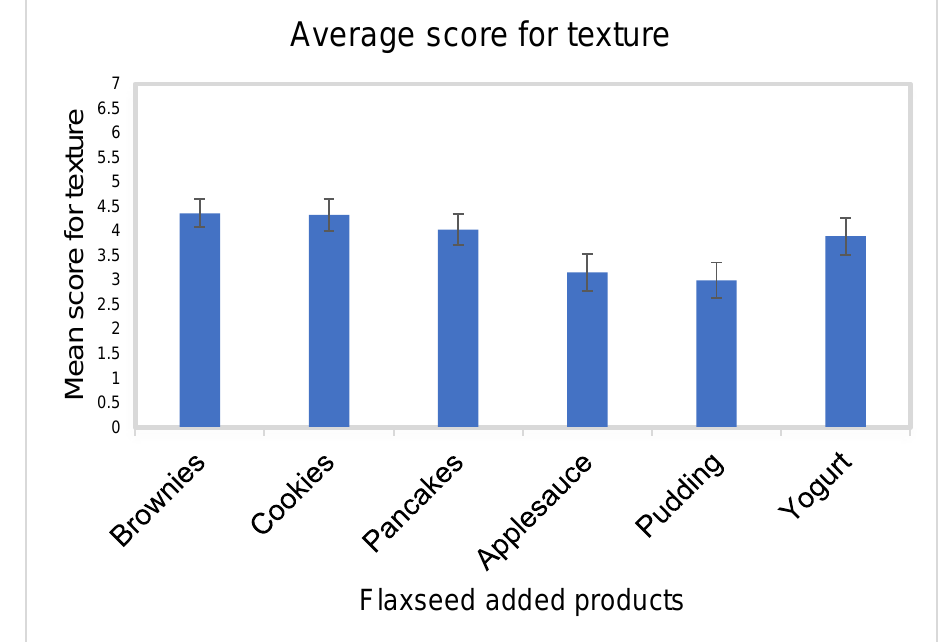
Figure 4. Mean score with SEMs for texture for all flaxseed products.